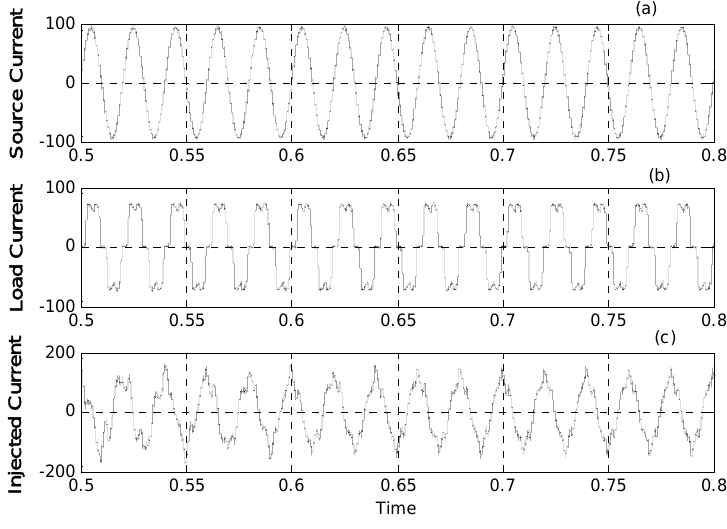
Figure 5a. “Source Current”; 5b. “Load Current”; 5c. “Inverter Current”.